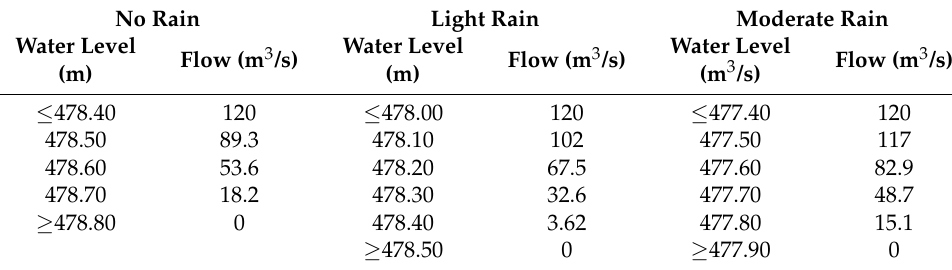
Table 6. Minimum replenishment ecological